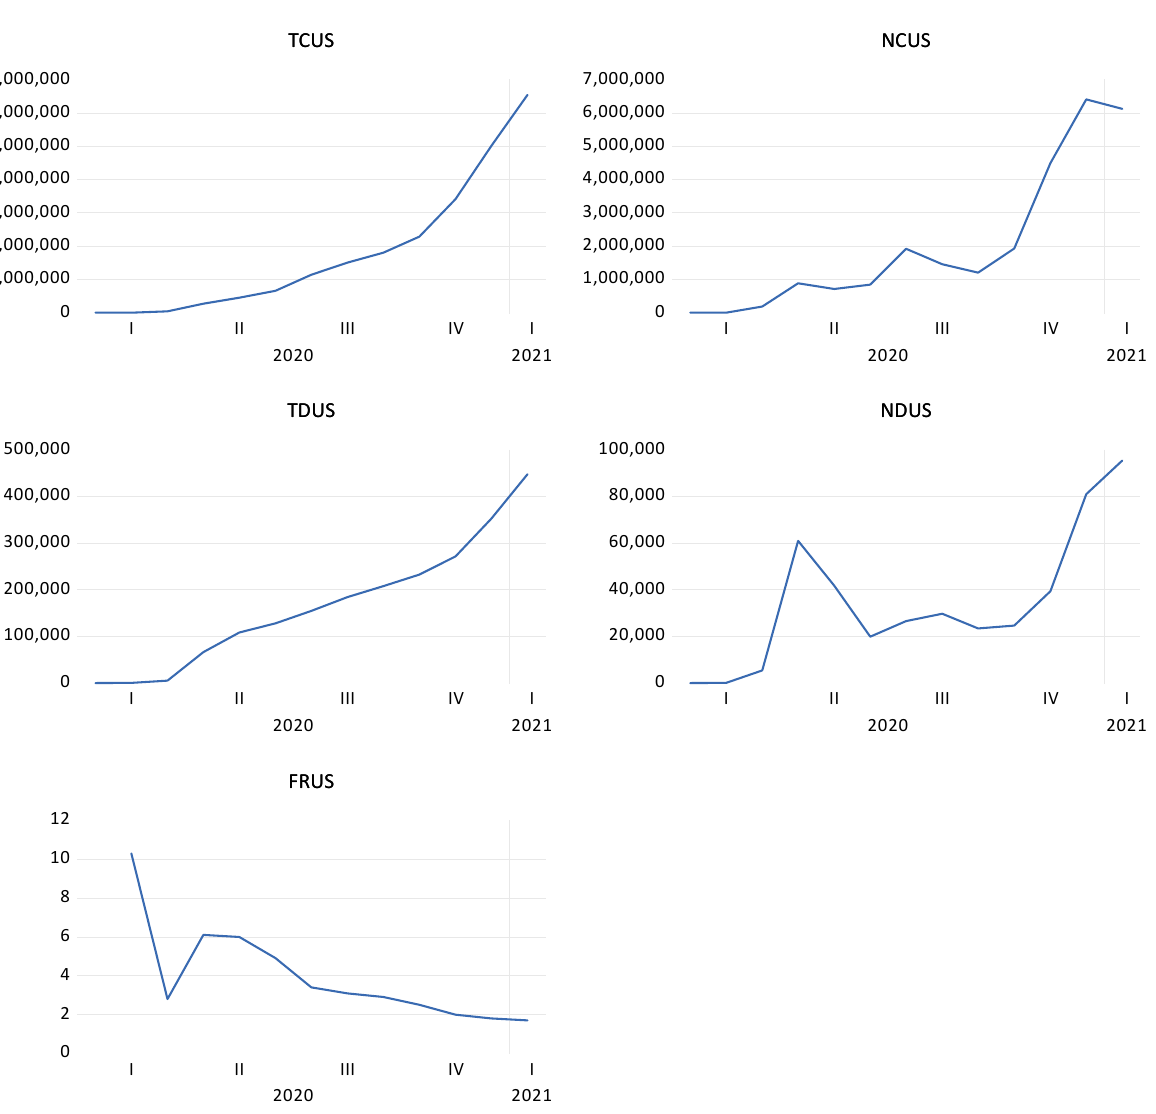
Figure A2. Source: compiled by the authors based on World Health Organization Coronavirus Disease 2019 (COVID-19) situation reports and the Our World in Data Coronavirus Pandemic (COVID-19) (Roser et al. 2020) database. Note: I = 1st quarter, II—2nd quarter, III—3rd quarter, IV—4th quarter. For TCUSt, NCUSt, TDUSt, NDUSt, and FRUSt, see Table 1.